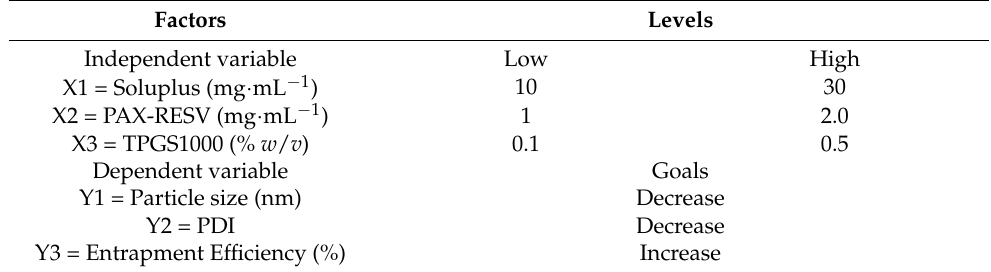
Table 1. Variables in Box Behnken design for preparation and optimization of PAX and RESV PNPs.